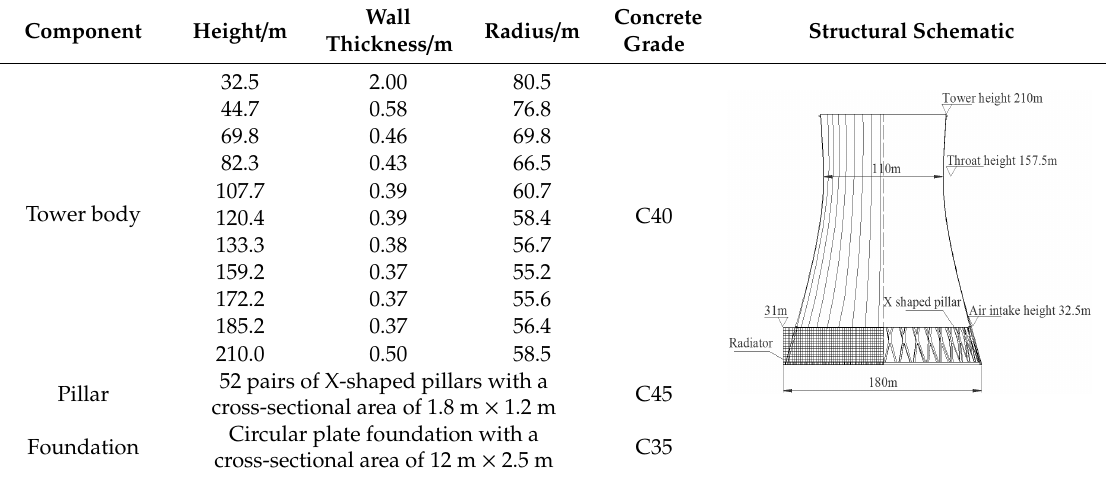
Table 1. Main structural parameters of super large cooling tower.